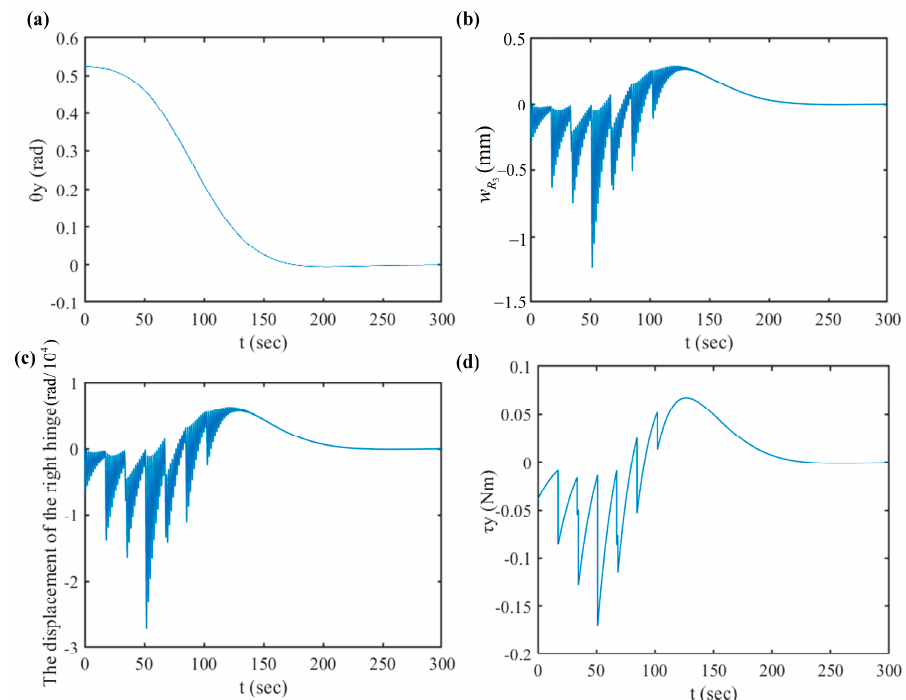
Figure 17. Time responses of the flexible spacecraft for using the PD + IS control ( k = 500 N · m/rad); they are listed as: ( a ) the displacement of θ y ; ( b ) the displacement of the 3rd-right panel tip; ( c ) the displacement of the right hinge B R